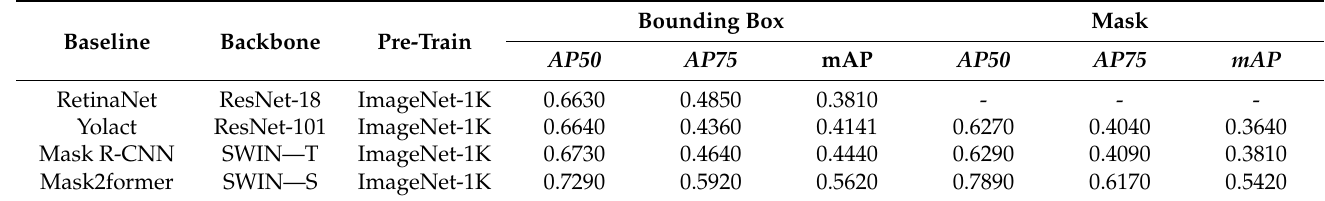
Table 2. Assessment of different state-of-the-art baselines and backbones for the detectability of declining or dead ash trees by using mean average precisions ( mAP ) and the threshold average precisions at 50% and 75% ( AP50 and AP75 , respectively).